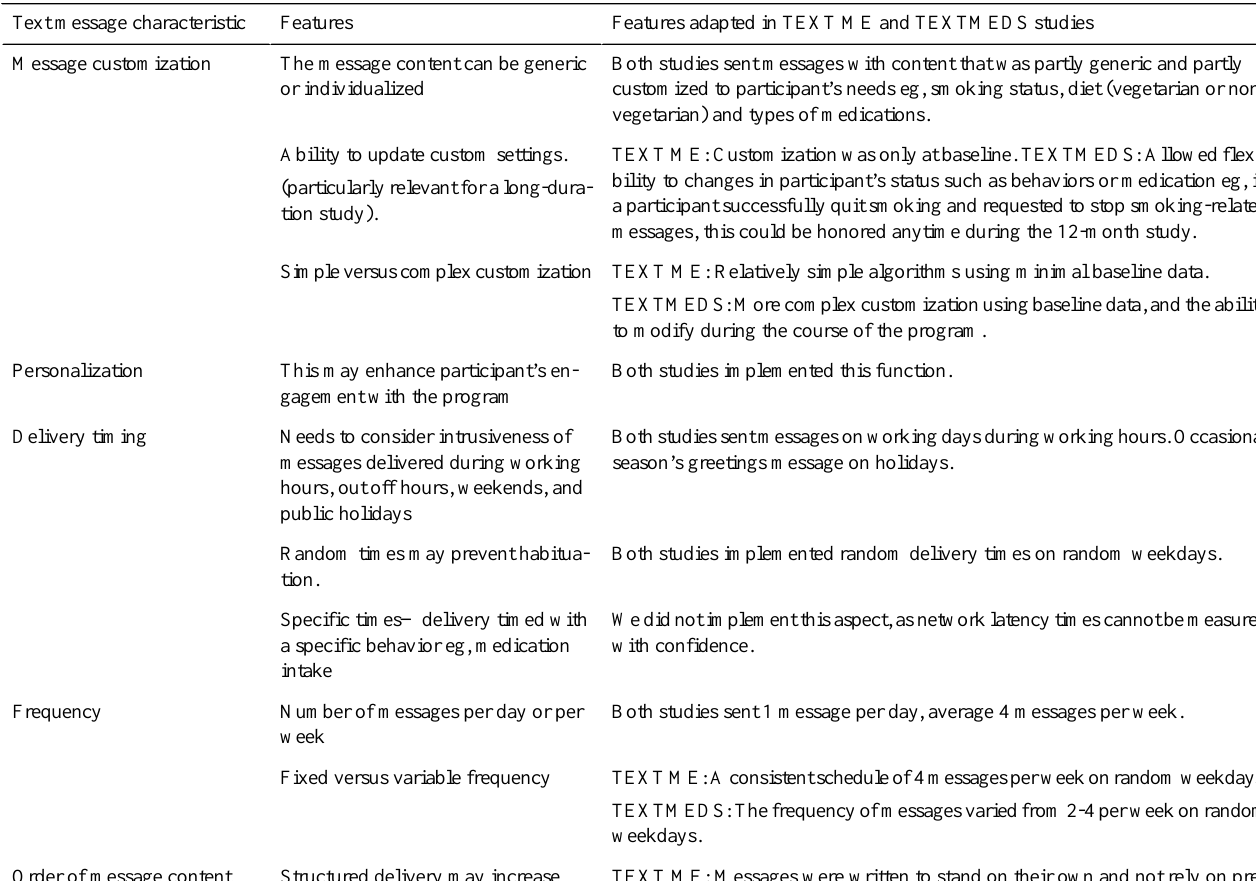
Table 2. Text message characteristics that merit consideration during the design phase.